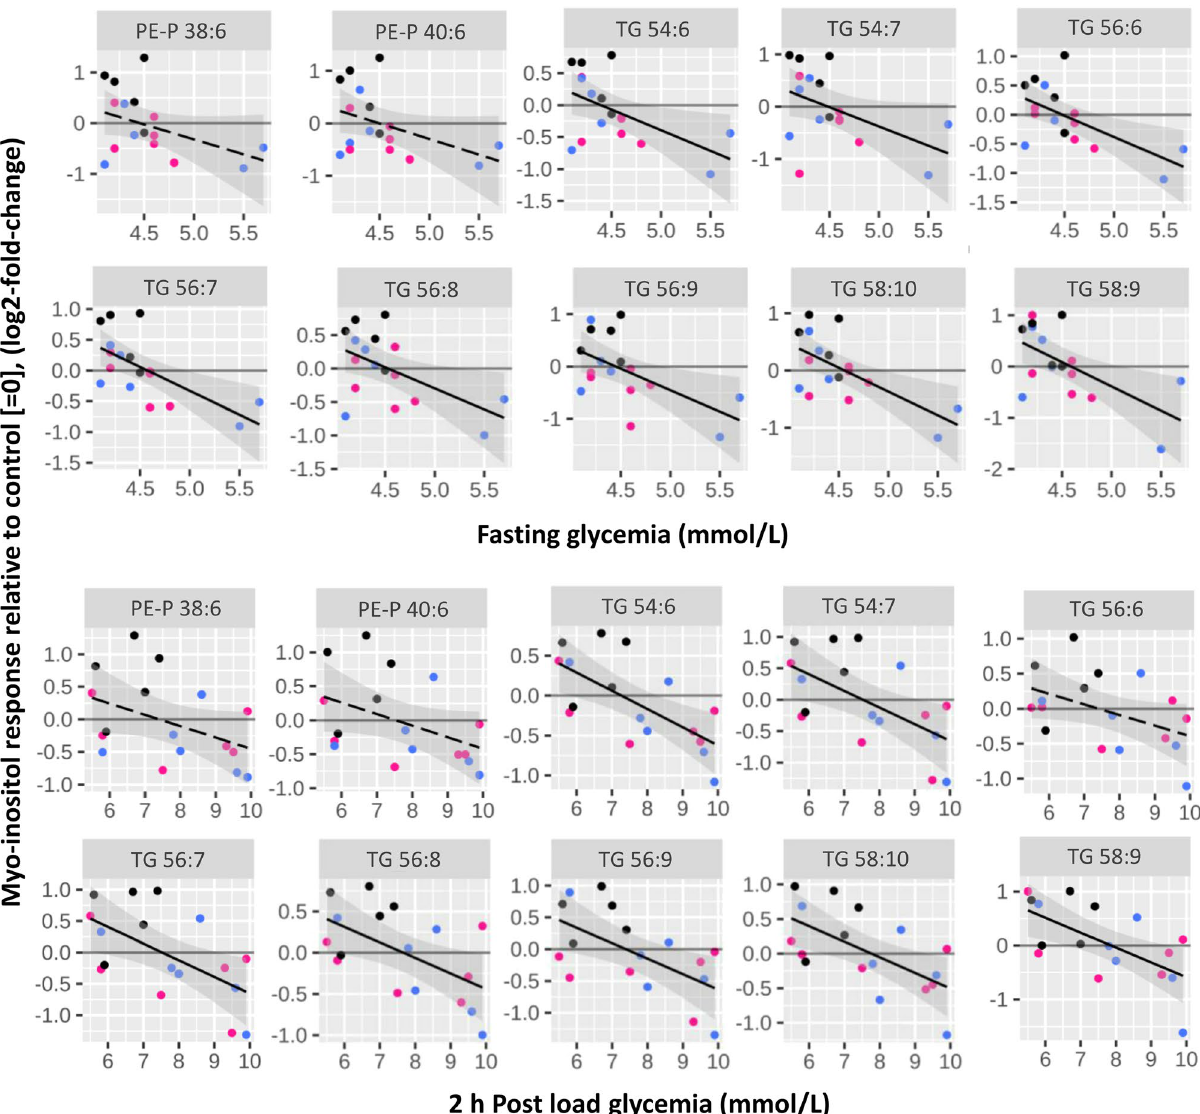
Figure 2. Associations between maternal glycemia (fasting or 2 h post-load) and 13 C-DHA lipid in response to myo-inositol treatment (myo-inositol response). Myo-inositol response represents the relative amount of 13 C-DHA lipid in placental explants treated with myo-inositol (60 µmol/L) compared with control explants from the same placenta not treated with myo-inositol. Positive values for myo-inositol response (log2-fold-change) indicate an increase in 13 C-DHA lipids compared with control (= 0), whilst negative values indicate a decrease. Linear regression was run with myo-inositol response as the outcome and maternal glycemia as the exposure/ predictor variable. The Benjamini-Hochberg (BH) method was used to correct for multiple testing. Solid lines show statistically significant associations, while dashed lines show non-significant trends. Shaded areas show 95% confidence intervals. Black: Normal BMI (< 23 kg/m 2 ), Blue: overweight (BMI 23 to < 27.5 kg/m 2 ), Pink: obese (BMI ≥ 27.5 kg/m 2